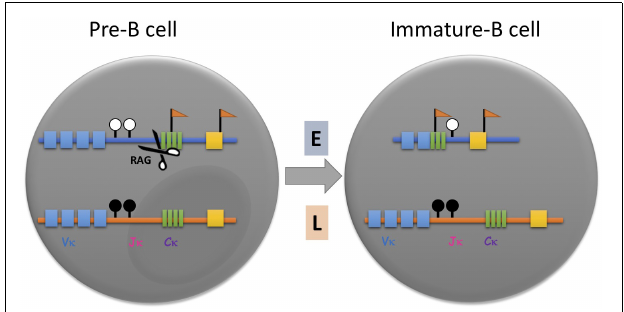
FIGURE 1 | Asynchronous replication timing (ASRT) and its role in immunoglobulin allelic exclusion. In pre-B cells prior to Ig κ rearrangement, the two unrearranged alleles, one of which replicates early (E, blue) and the other of which replicates later (L, orange), are marked with different epigenetic marks. The early replicating allele is hypomethylated at the DNA level (white lollipops) and enriched with hyperacetylated histones and methylation of histone H3 lysine 4 (flags). The late replicating allele is hypoacetylated, CpG methylated (black lollipops) and sequestered within heterochromatin. Once the pre-B cell senses a signal for rearrangement, the early replicating allele binds trans-acting factors such as B-cell-specific transcription factor, Pax5, and the rearrangement machinery (RAG), which binds to H3K4me3, thereby rendering it susceptible to rearrangement and progression to the stage of immature B cell. Thus, it is almost always the early replicating allele that undergoes rearrangement first. V κ , variable gene segments; J κ , joining gene segments; C κ , constant